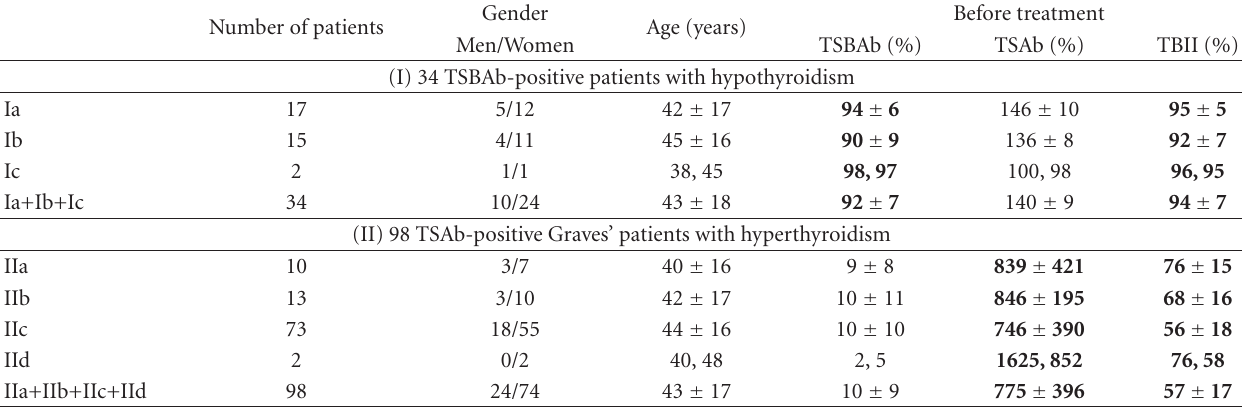
Table 2: Characteristics of the 34 TSBAb-positive patients with hypothyroidism and the 98 TSAb-positive Graves’ patients with hyperthy-